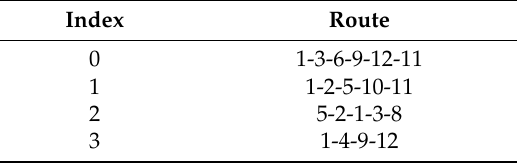
Table 9. An individual with 4 routes.